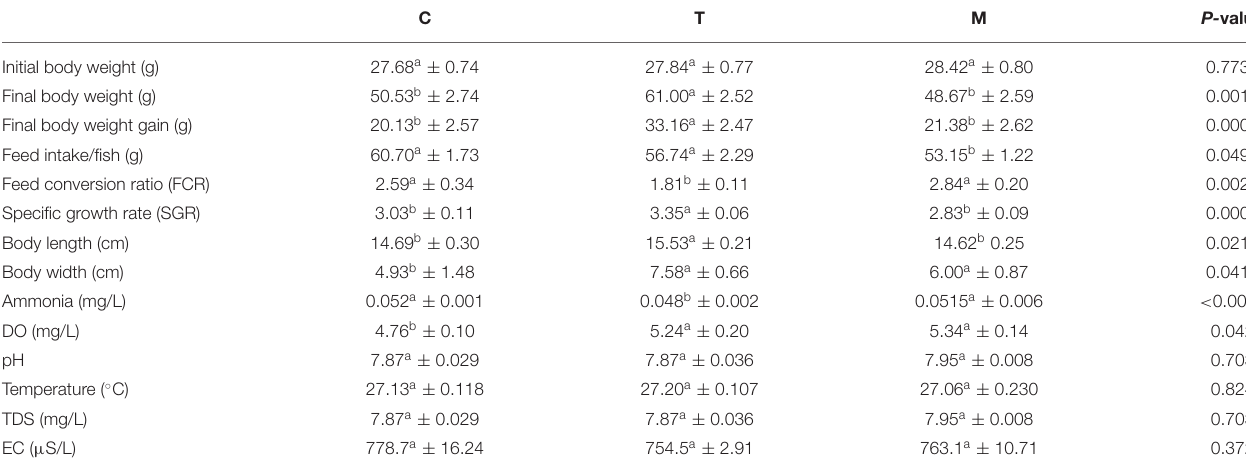
TABLE 3 | A summary of growth and water quality parameters